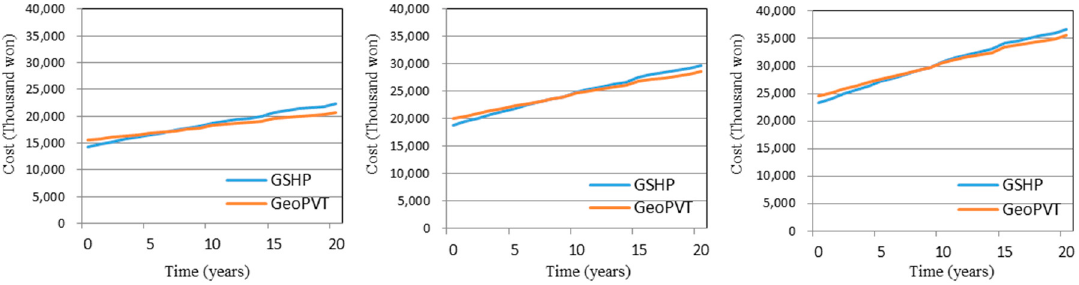
Figure 41. The result of life cycle cost.